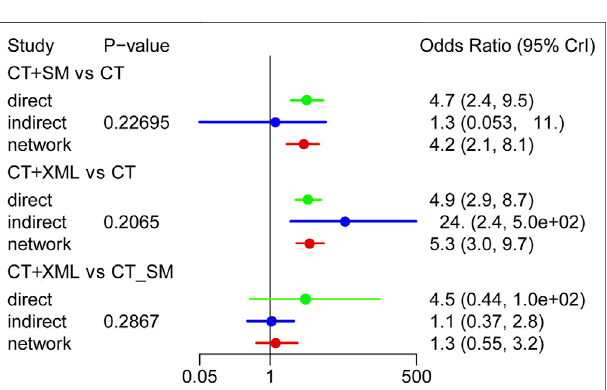
FIGURE7| ConsistencytestfortheNewYorkHeartAssociationcardiac functional classi fi cation ef fi ciency. CT, conventional treatment; SM, Shenmai injection; XML, Xinmailong